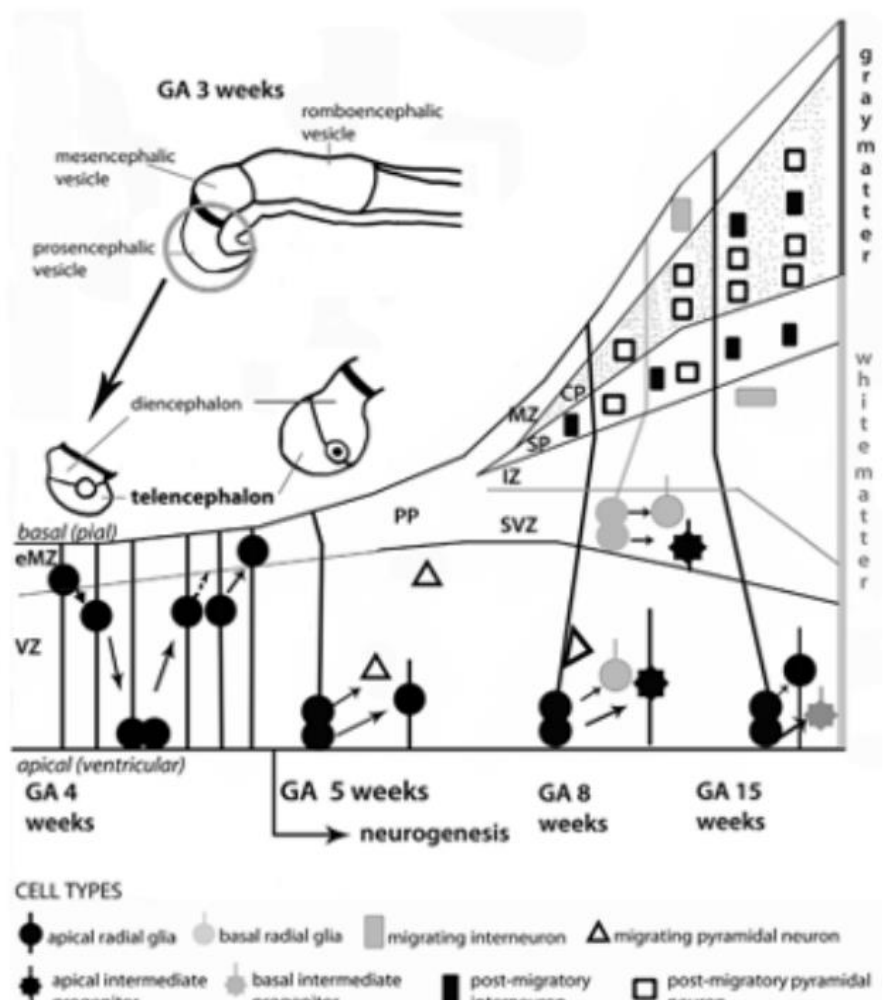
Figure 5. The neuro-ontogenic process starts at gestational age (GA) weeks 2–3 with the constitution of the neural tube. At GA week 4, the rostral portion of the neural tube forms the prosencephalic, mesencephalic and romboencephalic vesicles. The prosencephalic vesicle then forms two vesicles that are destined to become the telencephalon and the diencephalon (thalamus, hypothalamus, and other structures). The schematic diagram represents the development of telencephalon. Initially, the telencephalic primordium is constituted by dividing neuroepithelial cells (often called neural stem cells), characterized by interkinetic nuclear migration, which form the ventricular zone (VZ). There, one type of cells, the radial glial cells, are particularly prominent and distinctive. At GA week 4, they undergo early exponential proliferation increasing the number of progenitor/intermediate progenitor cells and the thickness of VZ. Early born neurons are interneurons which move within the marginal zone (MZ) and intermediate zone (IZ). The MZ will eventually form cortical layer I and, for some authors, MZ could be identified also before the cortical plate (CP) formation as early MZ (eMZ). The IZ is a cell-sparse compartment and exists before the appearance of the CP. Radial glial cells and intermediate progenitor cells can be classified in two distinct subpopulations: apical, resident in VZ with bipolar fibers, and basal, which delaminate from VZ with unipolar basal fiber. Apical progenitor cells in the VZ and basal progenitor cells in subventricular zone (SVZ) are considered the main source of pyramidal neurons. Around GA week 5, the neurogenesis begins, and the neuronal precursors proliferate rapidly within the VZ. The neurons located in the first recognizable cortical layer, known as the preplate (PP), form the earliest synaptic connections. PP is a transient structure present before the appearance of the CP. Around week 7, the PP cells contribute to the subplate (SP) which remains below the CP after its formation and contains post-migratory pyramidal neurons and